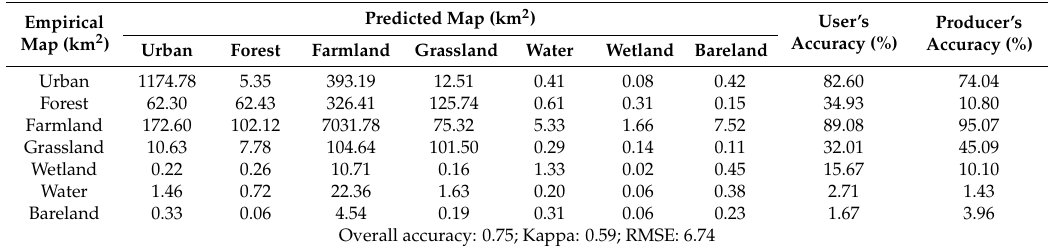
Table 7. Confusion matrix and model validation for the Markov-CA model.